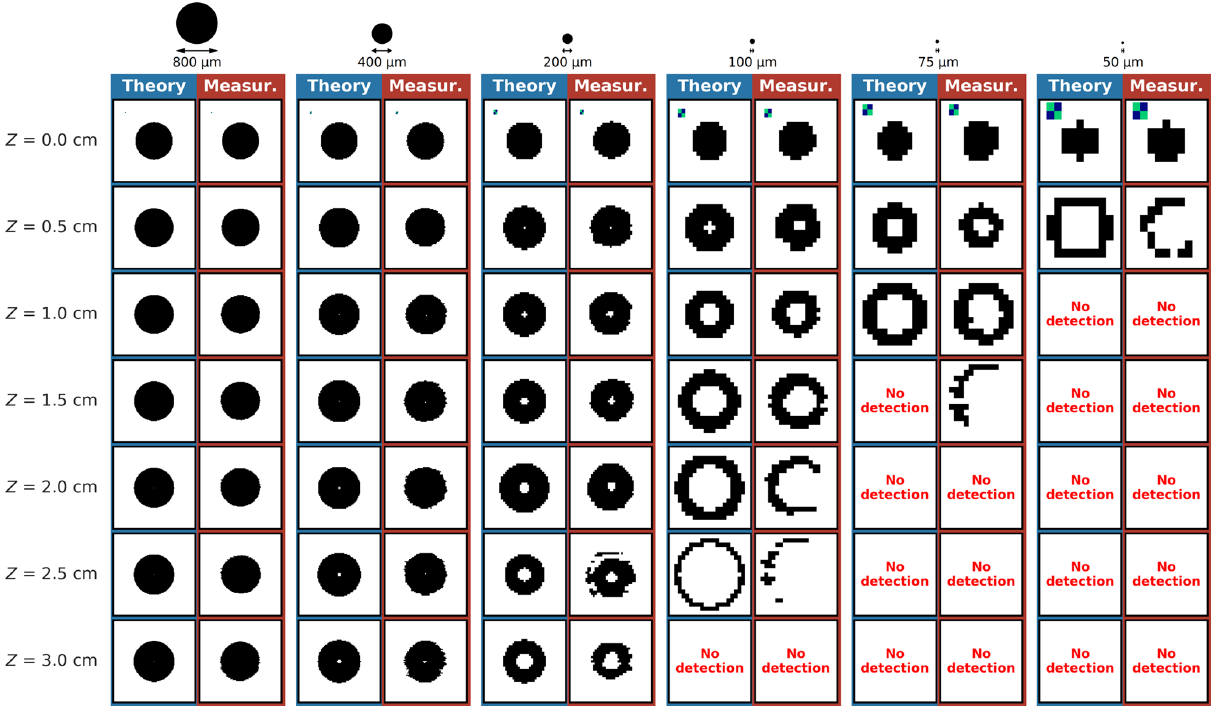
Figure B1. As Fig. 5 for opaque disc shape particles. Videos in the Supplement are available here: circular particle with radii